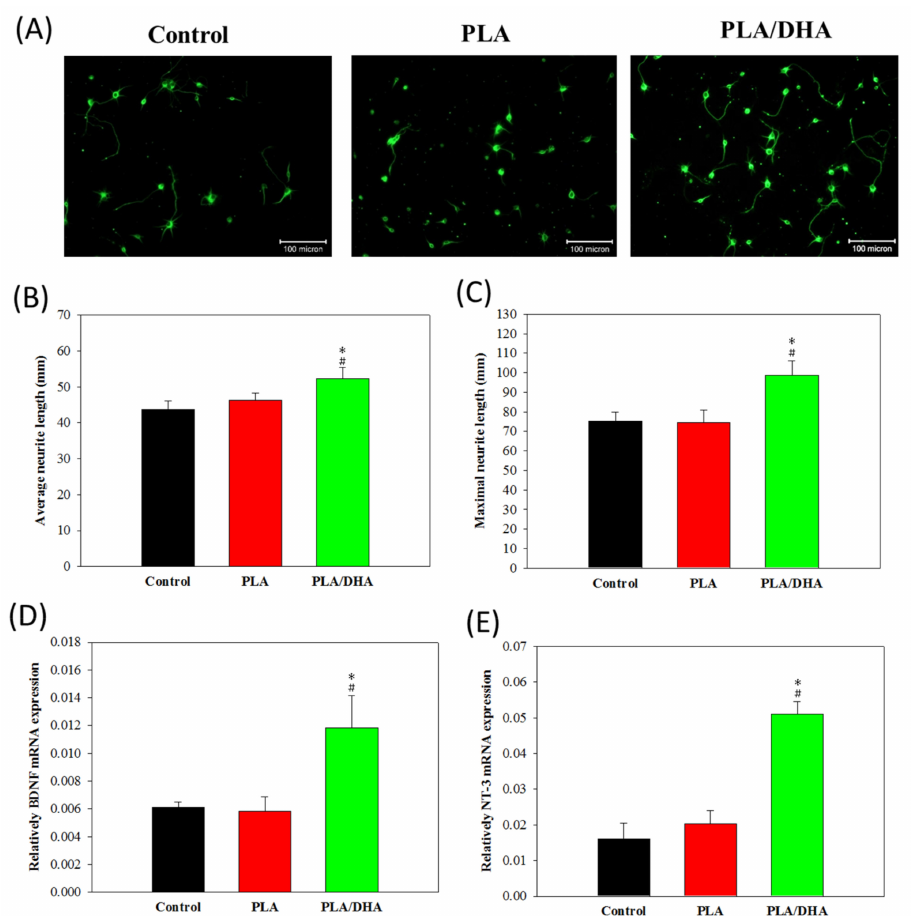
Figure 7. The neurite outgrowth was observed from β -tubulin III-positive primary cortical neuron cells under a fluorescent microscope after being co-cultured with polylactic acid (PLA) or polylactic acid / docosahexaenoic acid (PLA / DHA) core-shell nanofiber membrane in cell culture medium for 3 days (bar = 100 µ m) ( A ). The control was in the culture medium only. The average neurite length ( B ) and the maximum neurite length from neurite outgrowth was calculated for each neuron ( C ) using the ImageJ software ( n = 3, mean ± SD). The relative mRNA expression of brain-derived neurotropic factor (BDNF), ( D ) and neurotrophin-3 (NT-3) ( E ) neural marker gene was determined by real-time polymerase chain reaction (qRT-PCR). * p < 0.05 compared with control, # p < 0.05 compared with